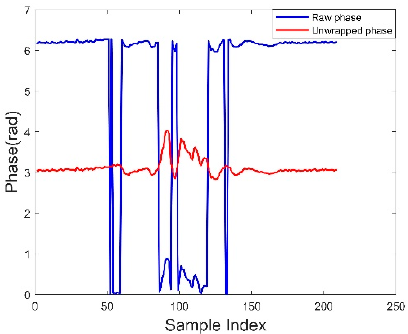
Figure 7. Comparison before and after phase unwrapping.